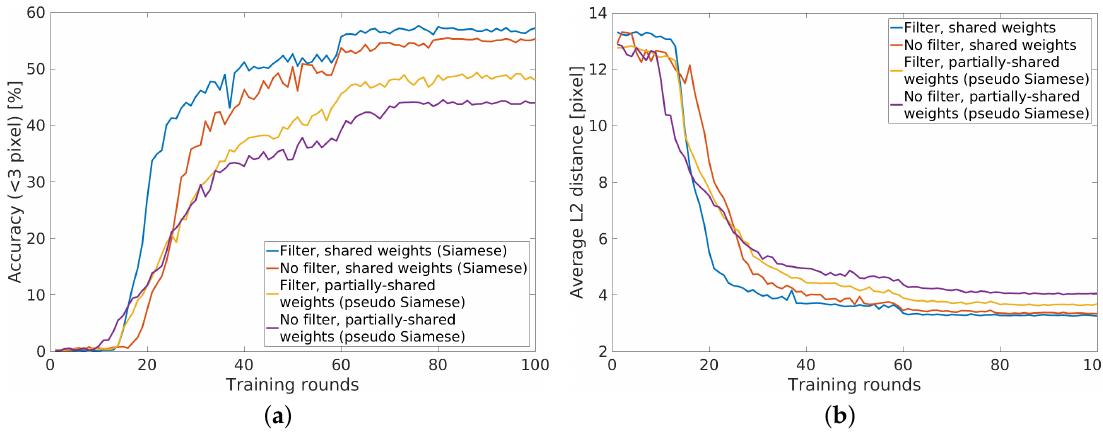
Figure 4. Influence of the speckle filter and comparison of different network architectures during training time (all results are generated from the validation set): ( a ) shows the matching accuracy during training. Here, the matching accuracy is measured as the percentage of matching points, where the L 2 distance to the ground truth location is less than or equal to three pixels; ( b ) shows the average L 2 distance between the matching points and the ground truth location during